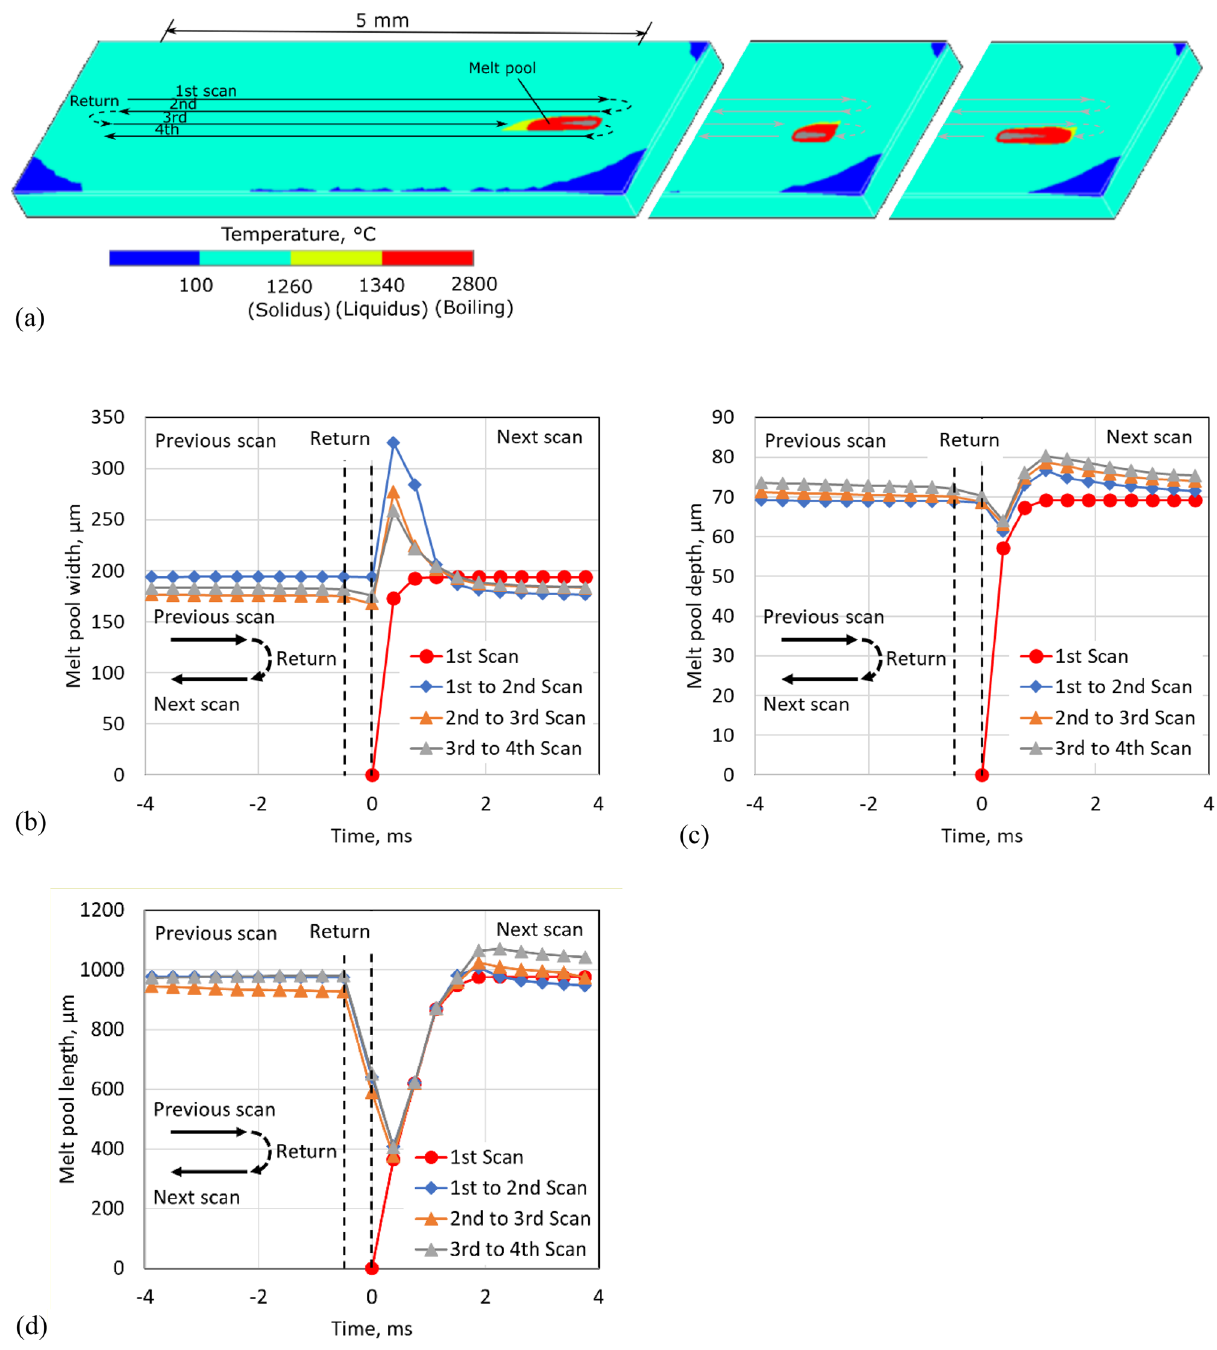
Figure 5. Temperature distribution of the PBF-LB process for Inconel 718. ( a ) Surface temperature distribution, ( b ) Melt pool around the turning point of laser scanning. ( c ) The depth and ( d ) width of the melt